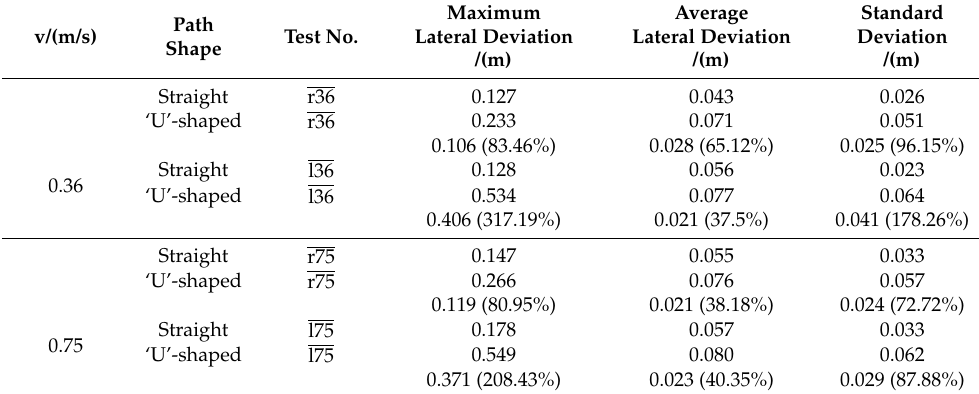
Table 8. Comparison of ‘U’-shaped and straight line path-tracking accuracy.